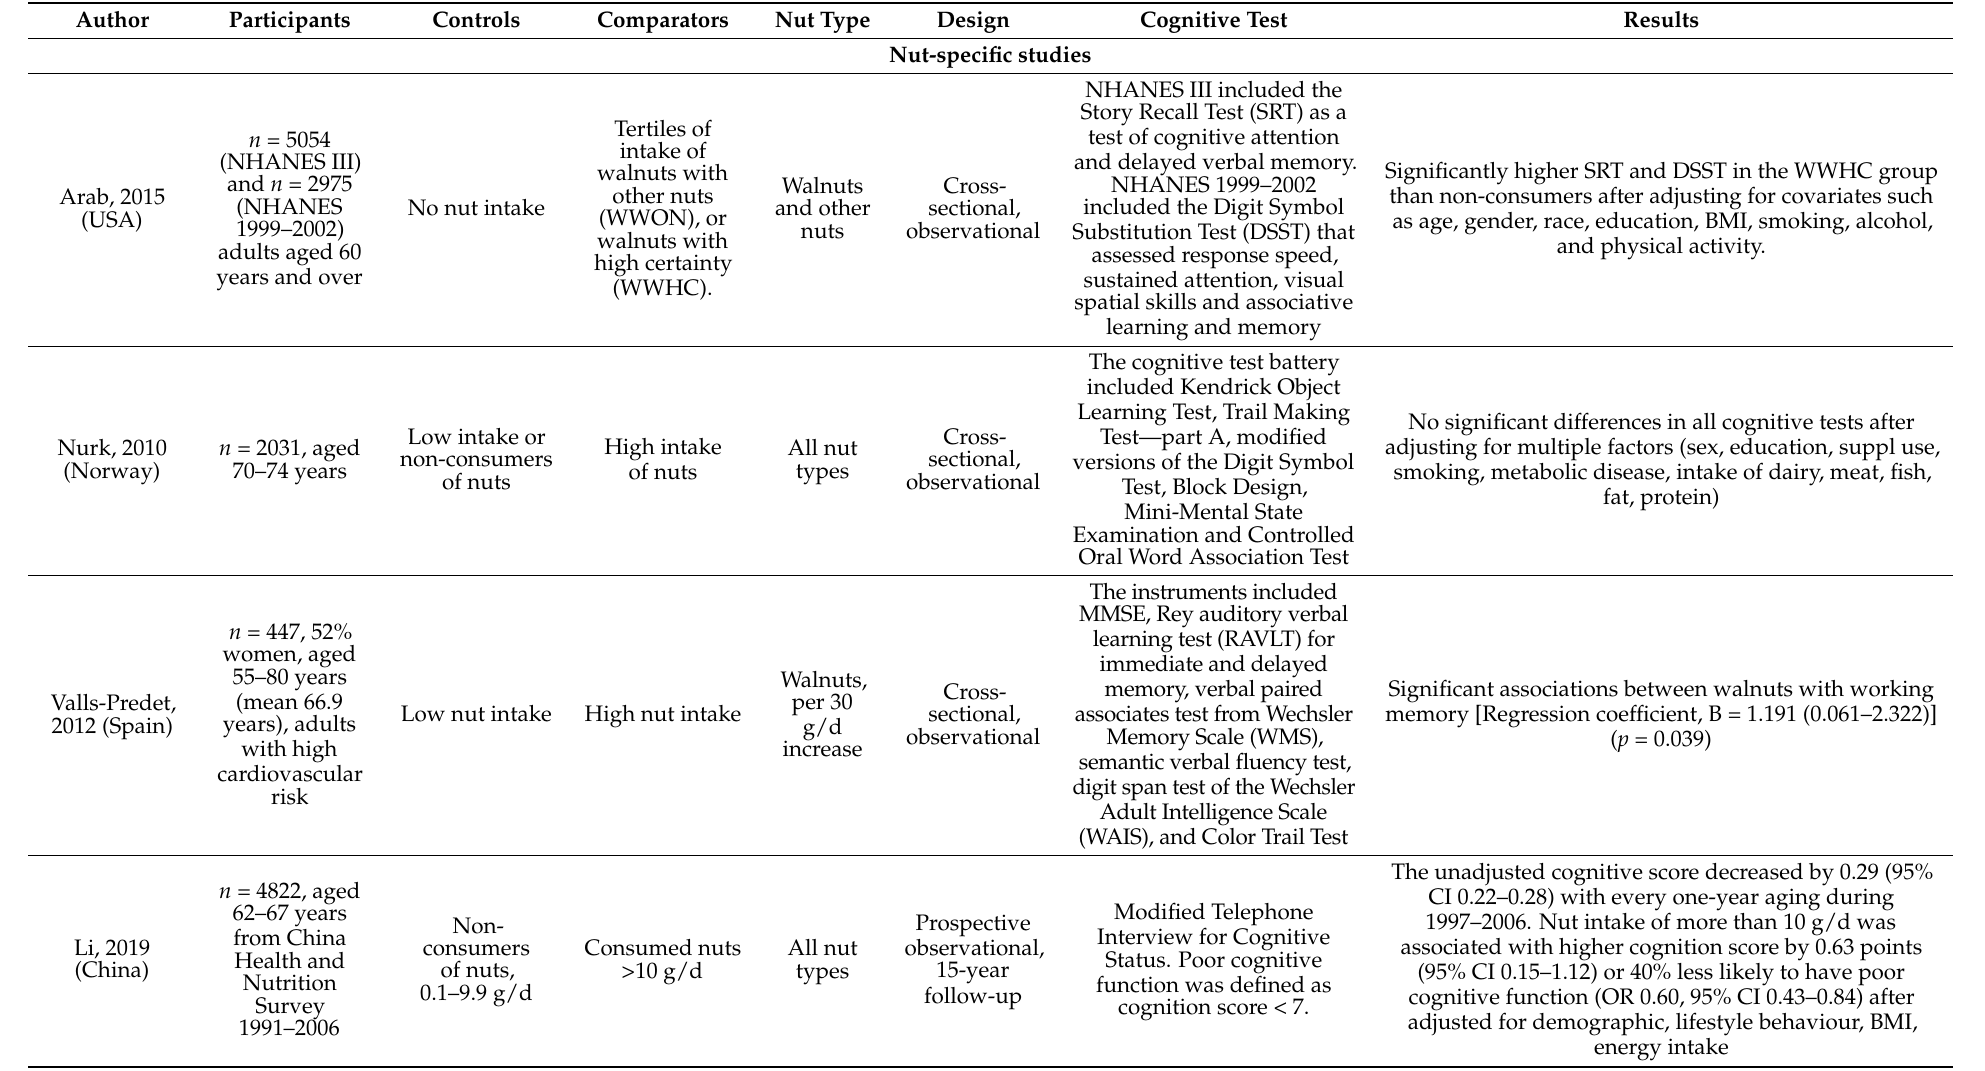
Table 3. Observational studies examining the association between nut consumption and